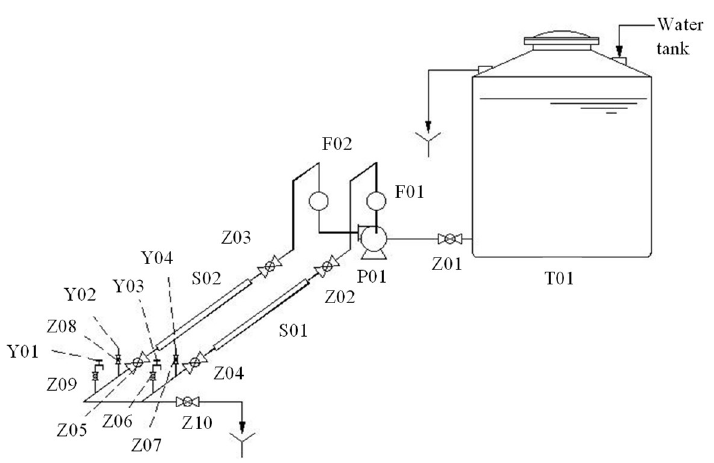
Figure 1. The simulative system of DWDS (F—flowmeter, P—pump, S01—ductile iron pipe, S02— polyvinyl chloride pipe, T—water tank, Y—outlet, Z—stopcock valve) . polyvinyl chloride pipe, T—water tank, Y—outlet, Z—stopcock